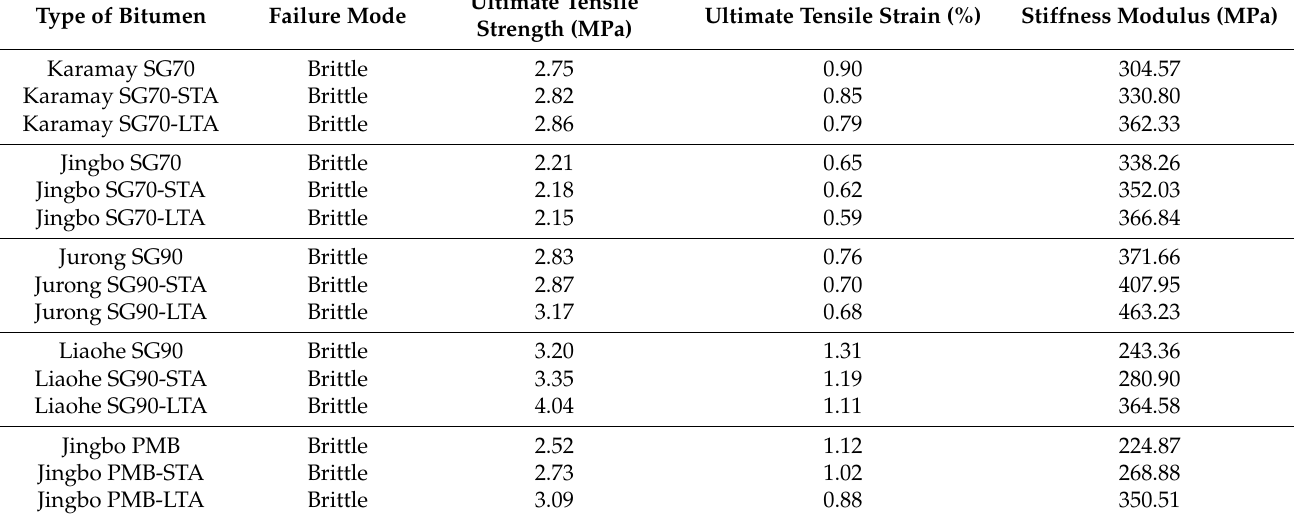
Table 11. Direct tensile test results at − 25 ◦